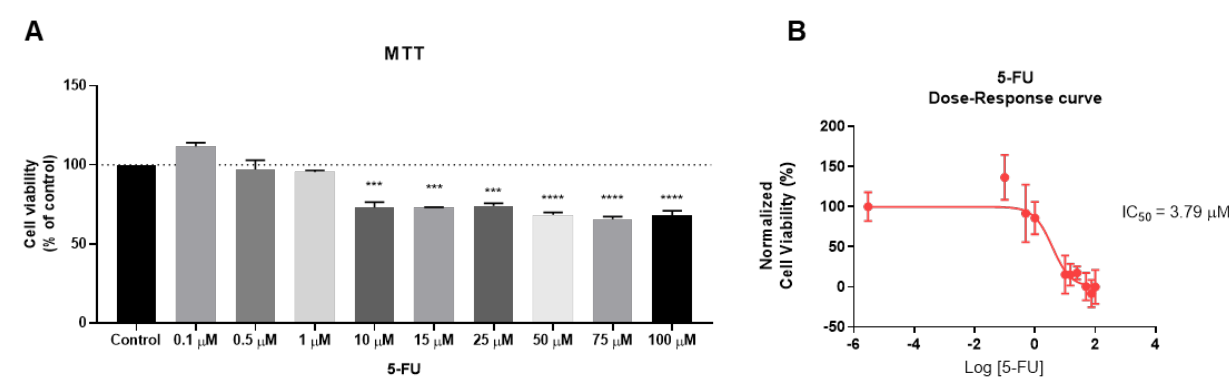
Figure 1. The effect of 5-FU on HT-29 cells. ( A ) Cell viability and ( B ) dose-response. Cells were cultured in the presence of increasing concentrations of 5-FU, and after 48 h, the MTT assay was performed to measure the cellular viability. Values are expressed in percentage of control and represent means ± SEM. Each experiment was done three times independently ( n = 3) *** statistically significant vs. control at p < 0.001. **** statistically significant vs. control at p < 0.0001.